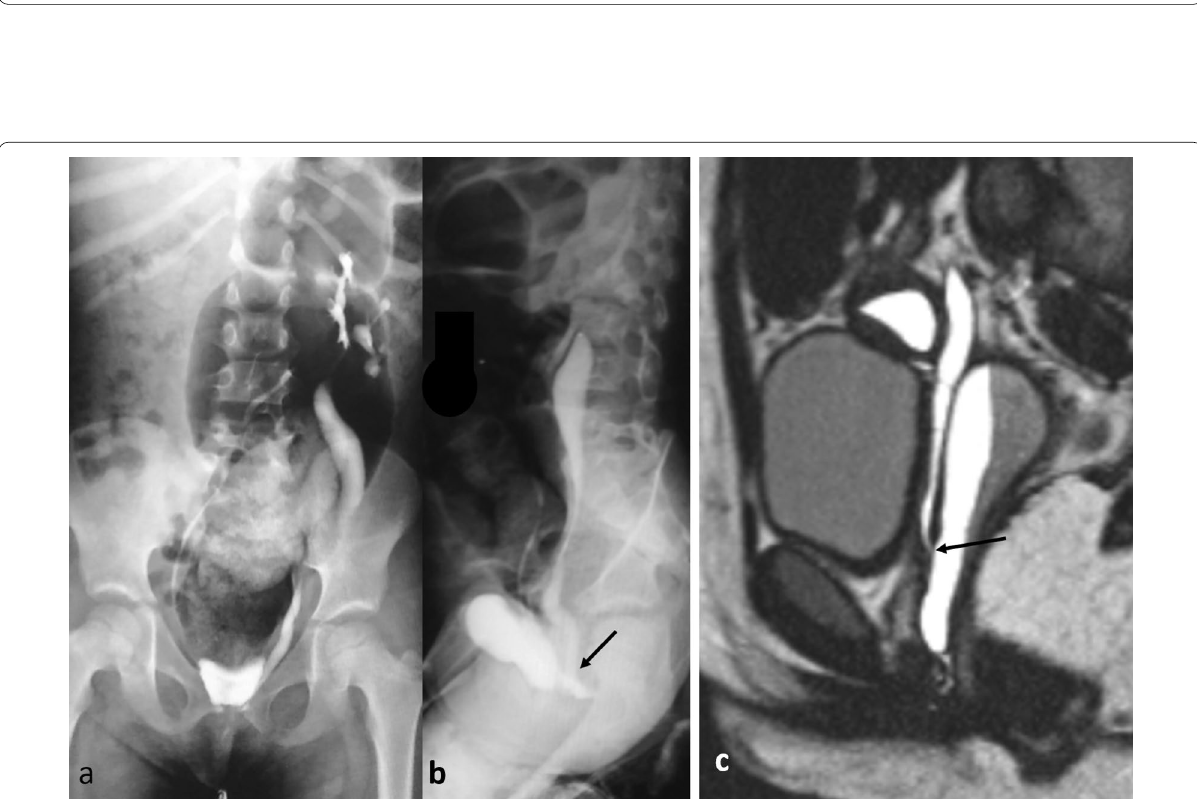
Fig. 10 Two different patients with urinary incontinence. a , b AP and lateral views of IVP of 2-year-old girl shows crossed fused ectopia with ectopic ureteric insertion into the urethra. c Sagittal high-resolution T2WI of the pelvis show ureteric insertion into the vagina which is seen dilated